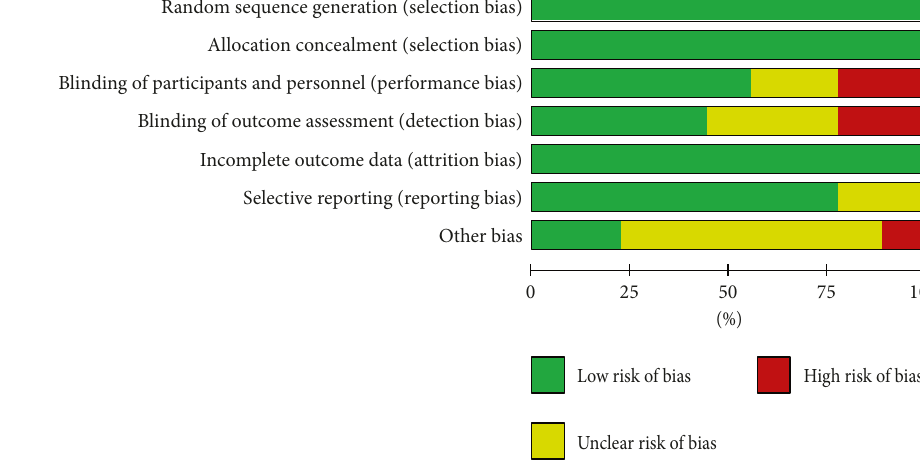
Figure 2: The results of the bias risk Table 2: Summary estimates and 95%CIs for total e ff ects of the probiotics.